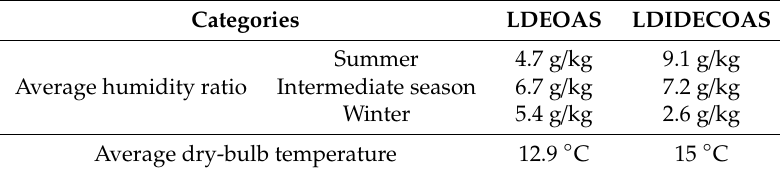
Table 9. Average humidity ratio of the supply air conditions of the two systems.